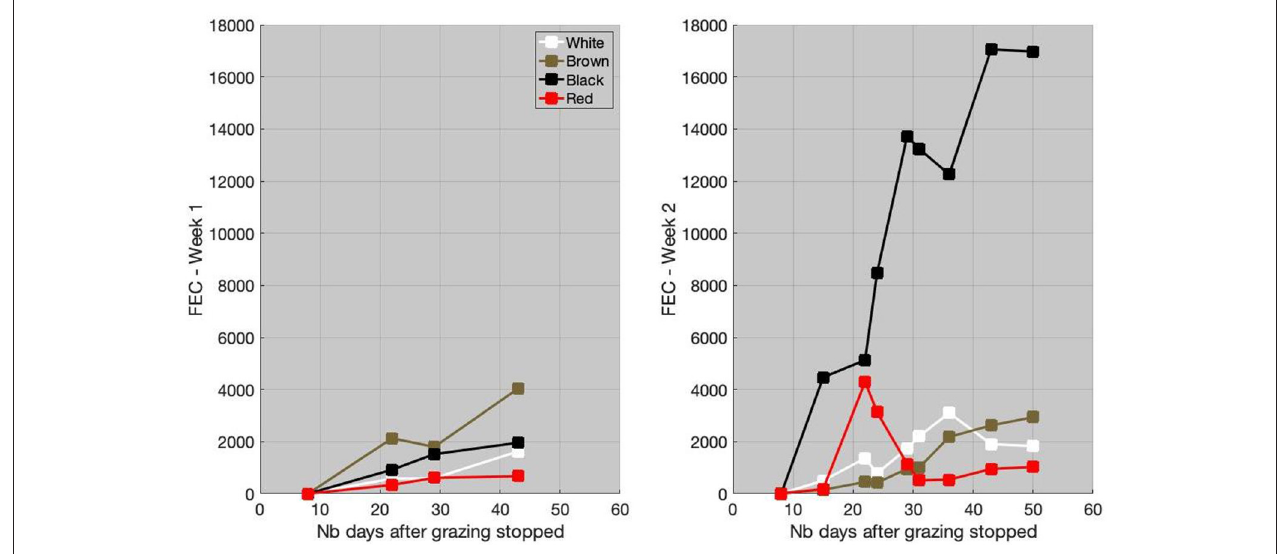
FIGURE 3 | Individual fecal egg count (FEC), in eggs/g of feces, for week 1 (left) and week 2 (right) , as a function of the number (Nb) of days after grazing stopped.